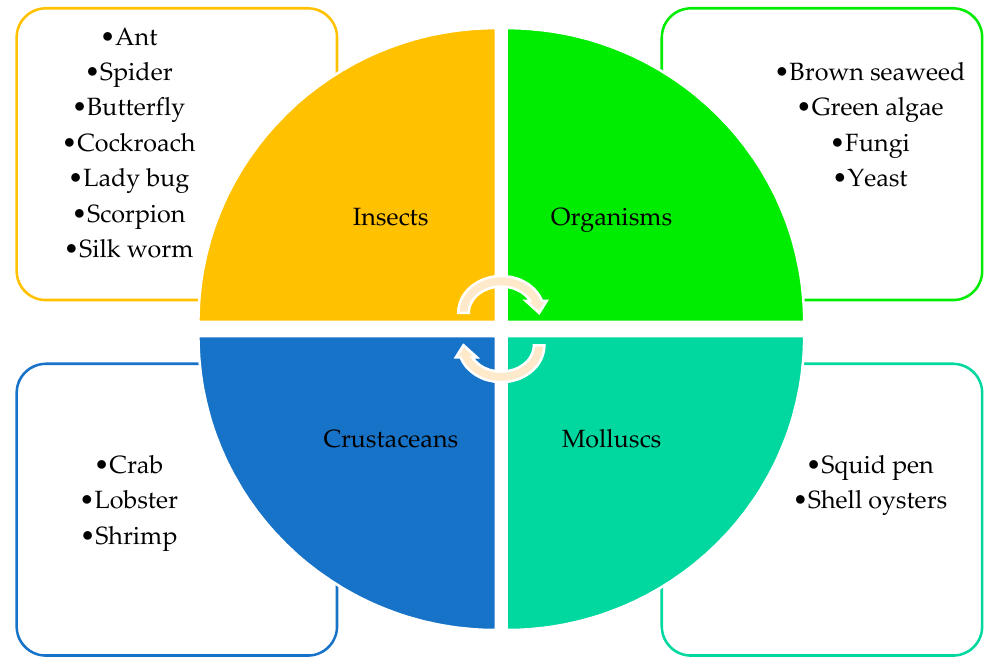
Figure 1. Chemical structures of chitin and chitosan.